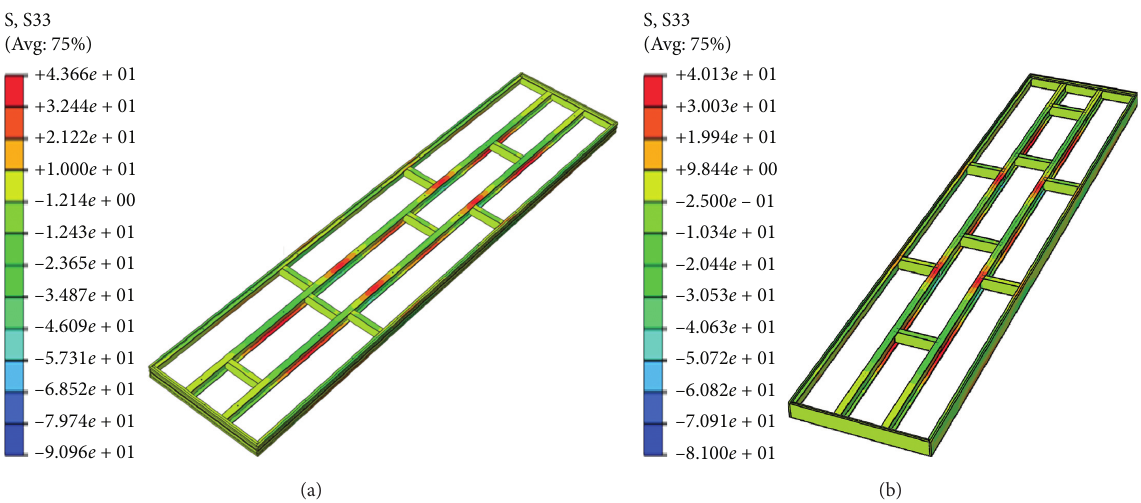
Figure 27: Longitudinal stresses of the frame (unit: N/mm 2 ). (a) Refined model. (b) General